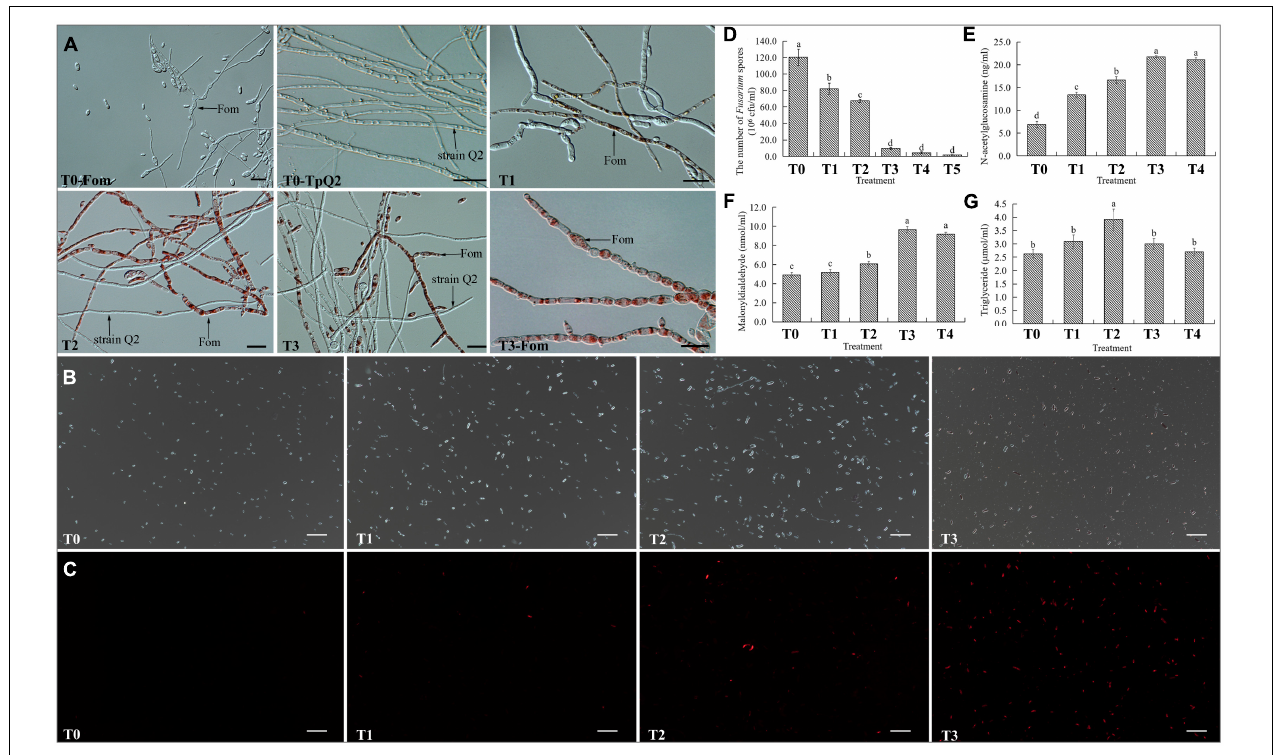
FIGURE 2 | Effects of TpQ2 on the growth and reproduction of Fom. (A) Micrographs showing Fom and TpQ2 hyphal morphology. (B,C) Determination of vitality of Fom conidia in the T1–T4 growth media after propidium iodide (PI) staining. (D) Numbers of Fom spores at 5 days post co-culture of TpQ2 and Fom. (E) Contents of N-acetylglucosamine in the liquid co-culture supernatant. (F) Contents of malondialdehyde from Fom spores produced during co-culture of TpQ2 and Fom. (G) Contents of triglyceride from Fom spores produced during co-culture of TpQ2 and Fom. Arrows indicate Fom and TpQ2 hyphae. T0-Fom, Fom was grown in a medium in the absence of TpQ2. T0–TpQ2, TpQ2 was grown in a medium in the absence of Fom. T1–T5, The ratios of TpQ2 and Fom spores were 1:10, 1:1, 2:1, 5:1, and 10:1, respectively. Scale bars = 20 µ m. Different letters in the same column indicate significant statistical difference at P < 0.05 level determined using the Student-Newman-Keuls test, the below is